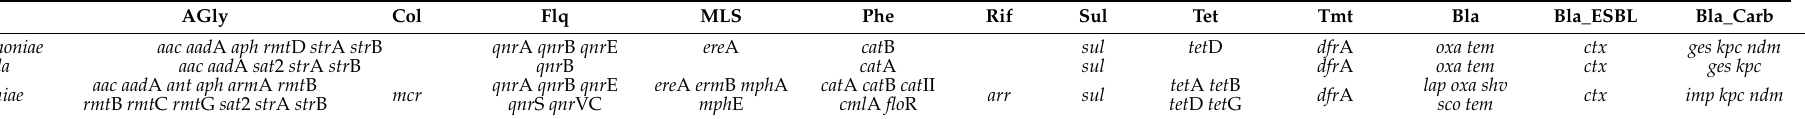
Table 1. Antibiotic resistance genes identified in the genomes of Klebsiella species.